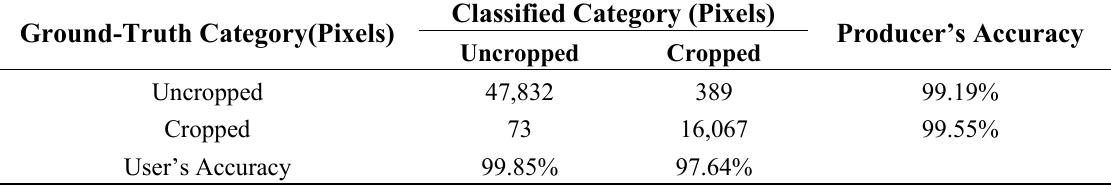
Table 4. Error matrix and accuracy for 2011 cropped/uncropped map.